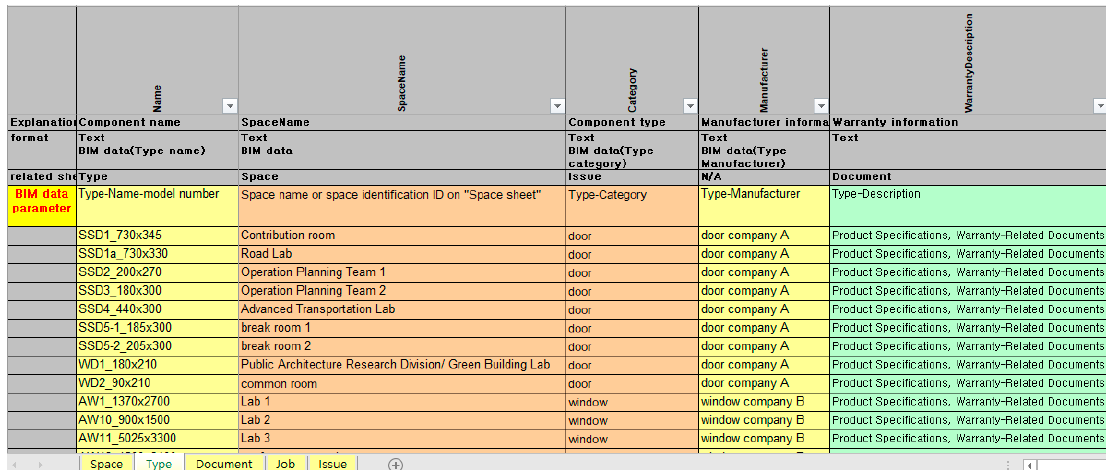
Figure A4 . COBie ‘Type’ datasheet.